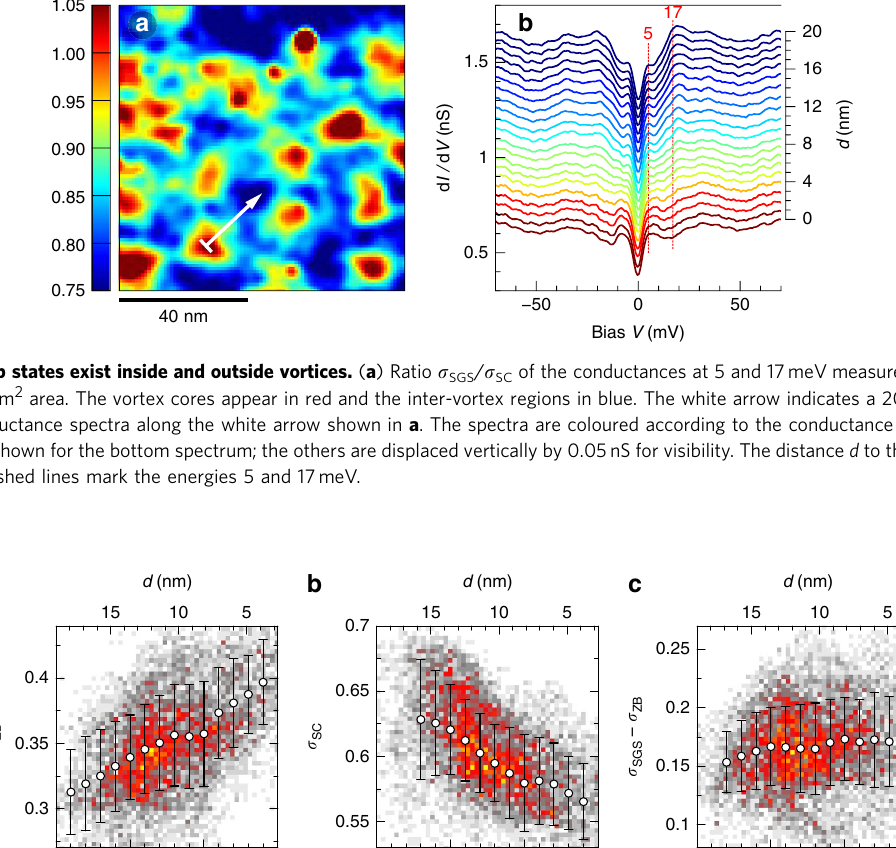
have verified in the experimental data. Figure 4 confirms the lack of sensitivity of the SGS to the SC. A vortex-core spectrum (Fig. 4a) is compared with two zero-field spectra without coherence peaks, at a twin boundary 26 (Fig. 4b), and inside an extended region of the sample surface where no SC was detected (Fig. 4c). All three spectra present the SGS feature at the same energy on top of different backgrounds. The PG feature appears to be also present in all three cases.